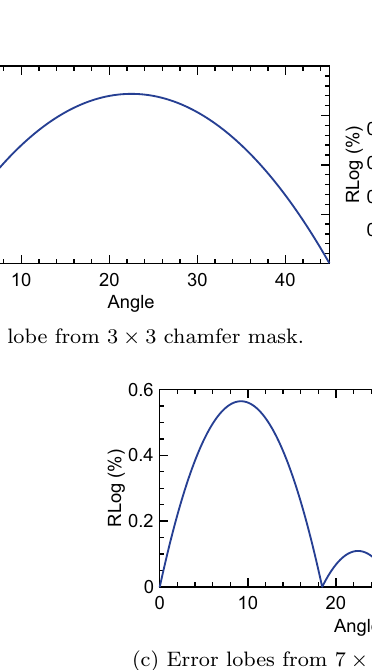
Figure 2. Operation of sequential distance transform.